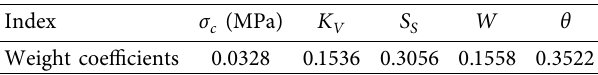
Table 5: The weight coefficient matrix.